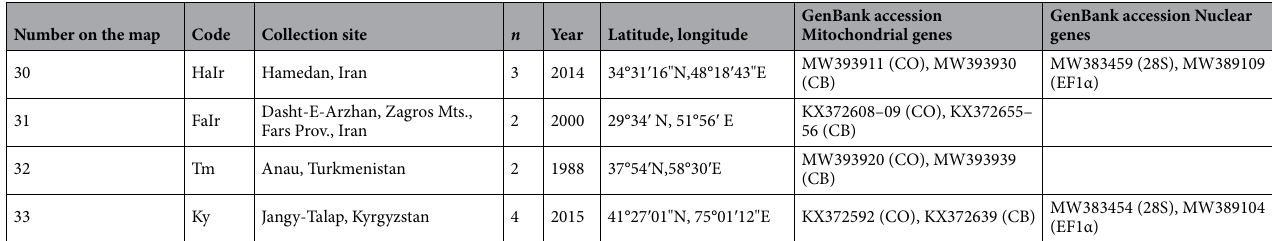
Table 1. Sample collection information for Hypera postica. CO: COI - tRNA Leu - COII. CB: Cyt b-tRNA Ser